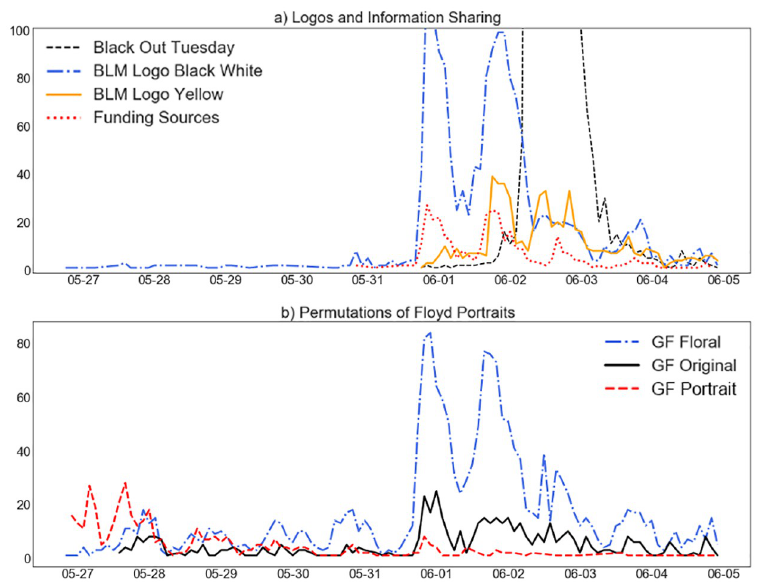
Fig 4. Time series of top icons diffused during the George Floyd protests. Fig 4a) shows the diffusion of the three BLM logos and the funding infographic. Fig 4b) shows the three iterations of George Floyd’s portrait. We observe much earlier volume in the portraits as compared to BLM and protest